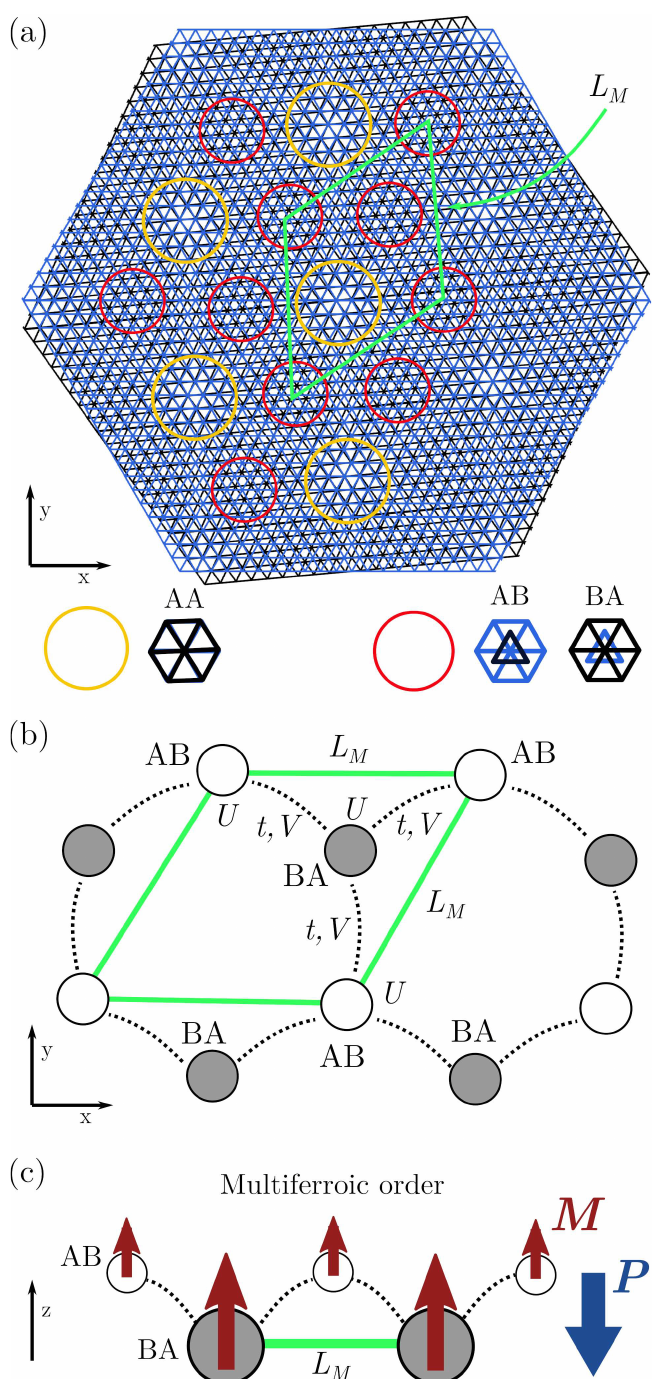
Figure 1: (a) Schematic of the twisted bilayer triangular lattice associated with the transition metal M of the MX . Sites AB and BA are structurally equivalent and 2 display a staggered honeycomb lattice with a lattice parameter corresponding to the moiré length L . (b) Staggered honeycomb lattice model. Moiré unit cell in M green and AB (BA) sites are depicted as white (gray) circles. First neighbor hopping t , on-site U , and first neighbor V Coulomb interactions are schematically shown. (c) Emergent ferrimagnetic and fully gapped charge density wave orders from the quarter-filling staggered honeycomb model. In this state, the electric charge gets more localized in the BA sites which leads to an emergent electric polarization in the staggered honeycomb